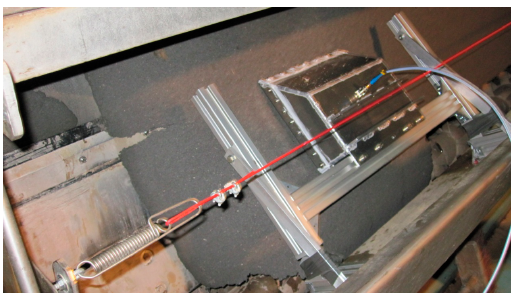
Figure 4. Biomaterial mat moving through the resonator halves during the factory experiments.